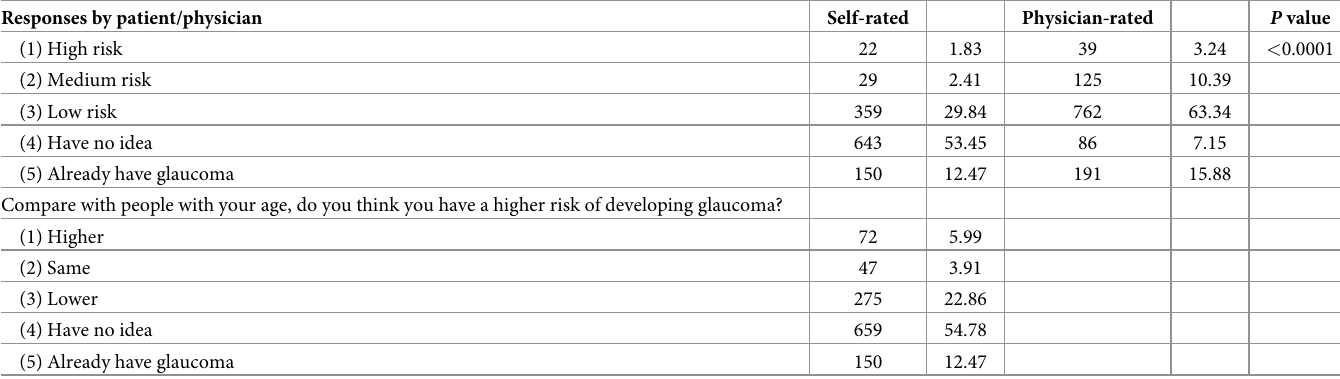
Table 1. Self-rated glaucoma risk and physician-rated glaucoma risk,